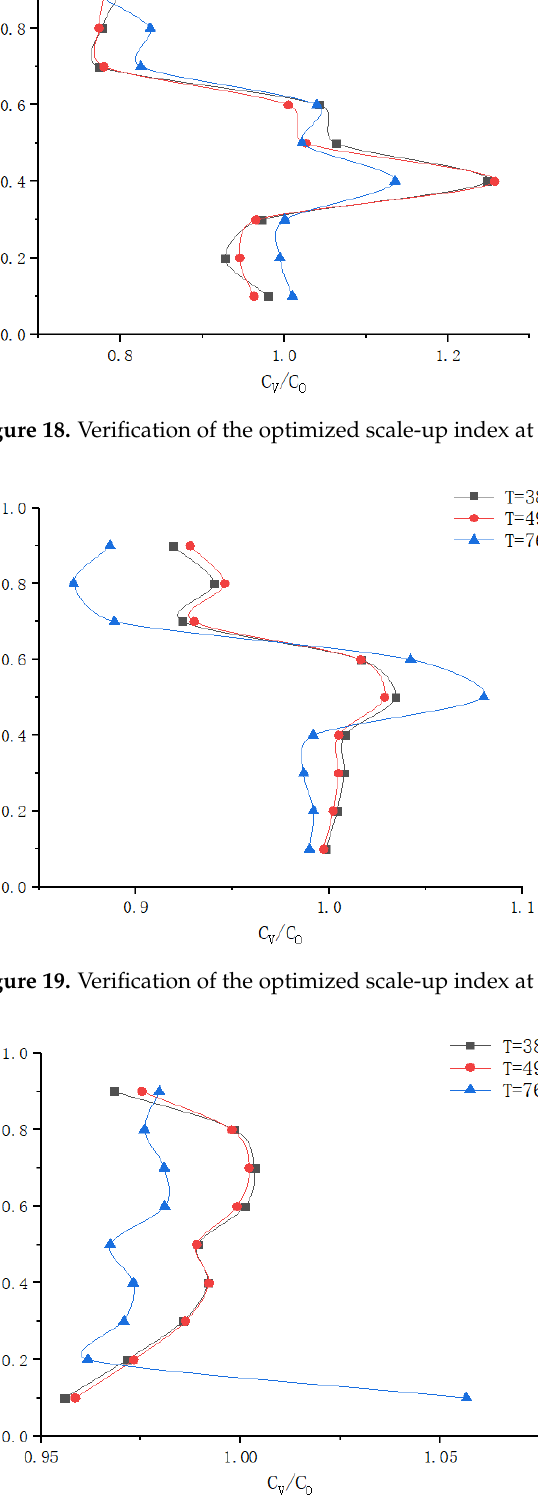
Figure 20. Verification of the optimized scale-up index at 15% v/v .